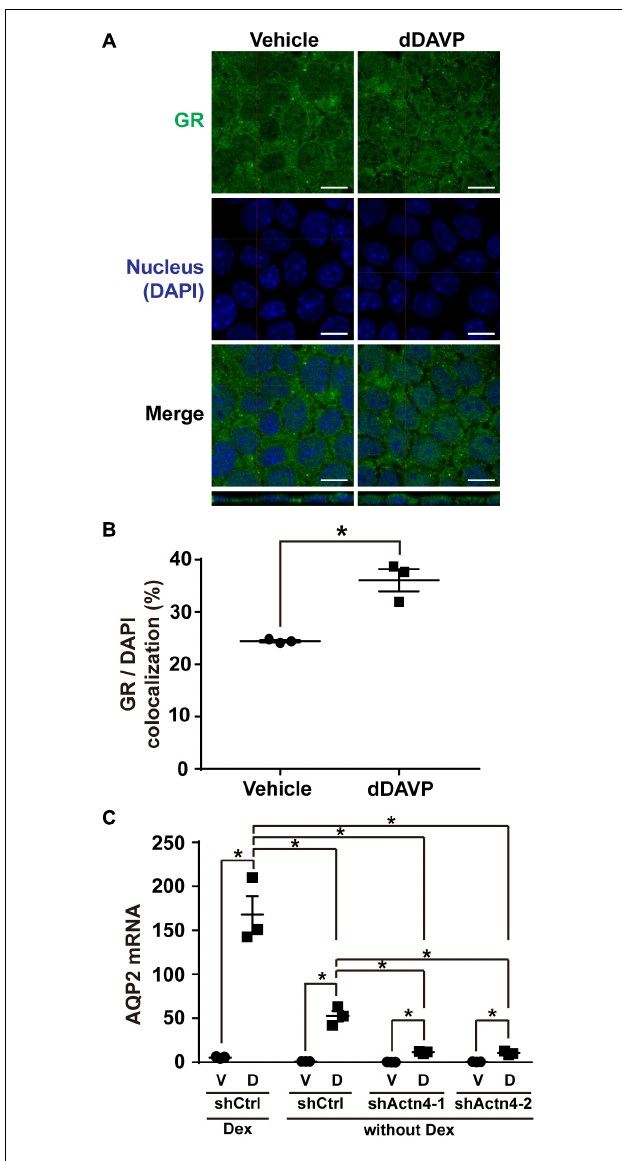
FIGURE 7 | Vasopressin-induced glucocorticoid receptor nuclear translocation and AQP2 mRNA expression were reduced in the absence of dexamethasone. (A,B) Representative and summary of confocal immunofluorescence micrographs of glucocorticoid receptor (GR) in the mpkCCD cells in response to vehicle or dDAVP in the absence of dexamethasone. The nuclei were stained with DAPI in blue. Numbers are means ± SEM, summarized from three independent experiments and about 330 cells per experiment. Asterisks indicate statistical significance, t -test p < 0.05. Bars indicate 10 µ m. (C) Quantitative RT-PCR measurements of AQP2 mRNA in the control (shCtrl) and α -actinin 4 knockdown (shActn4-1 and shActn4-2) mpkCCD cells in response to dDAVP (D) vs. vehicle (V) in the presence or absence of dexamethasone (Dex). Numbers are means ± SEM, summarized from three independent